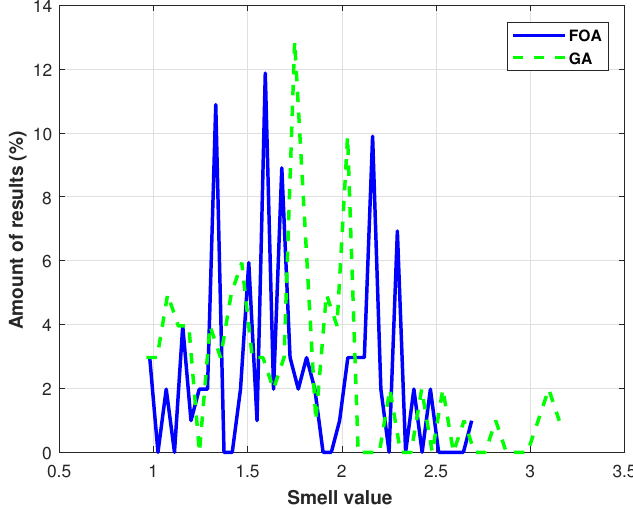
Figure 17. Comparison of the results provided by the implemented FOA and a commercial implementation of a GA. Smell FOA = 1.73, σ FOA = 0.41, Smell GA = 1.71, σ GA = 0.49. Mean value ( Smell x ) and variance ( σ x ) of the Smell function